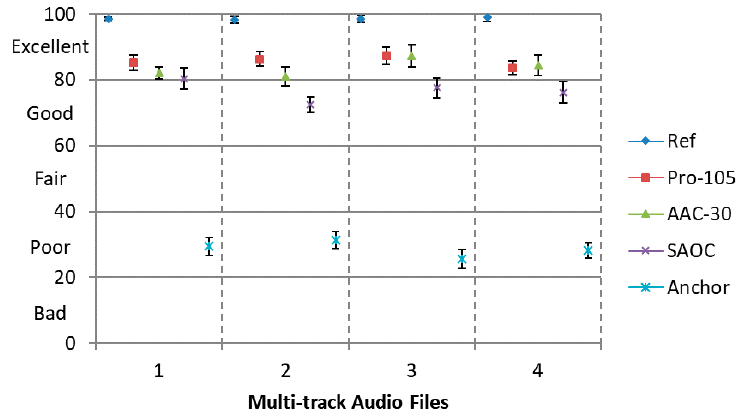
Figure 8. MUSHRA test results for separate AAC (Advanced Audio Coding) encoding at 30 kbps, SAOC (Spatial Audio Object Coding) and our proposed approach at 105 kbps with 95% confidence intervals.